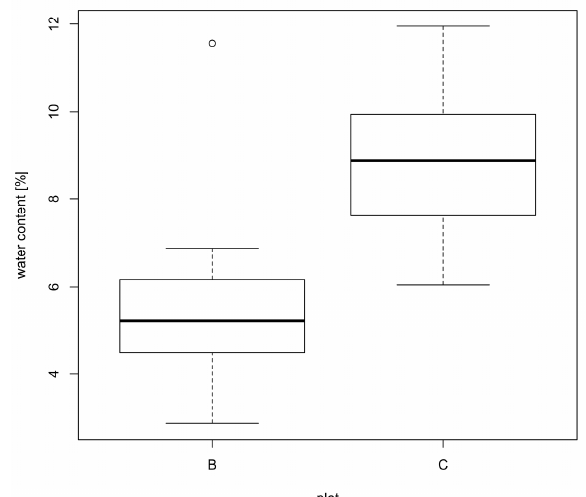
Figure 1. Soil moisture in plots bioturbated by wild boar (B) and control plots (C).